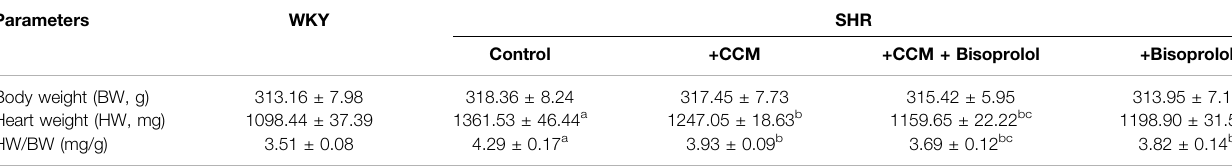
TABLE 1 | Characteristics of the fi ve groups of rats after 10 weeks of